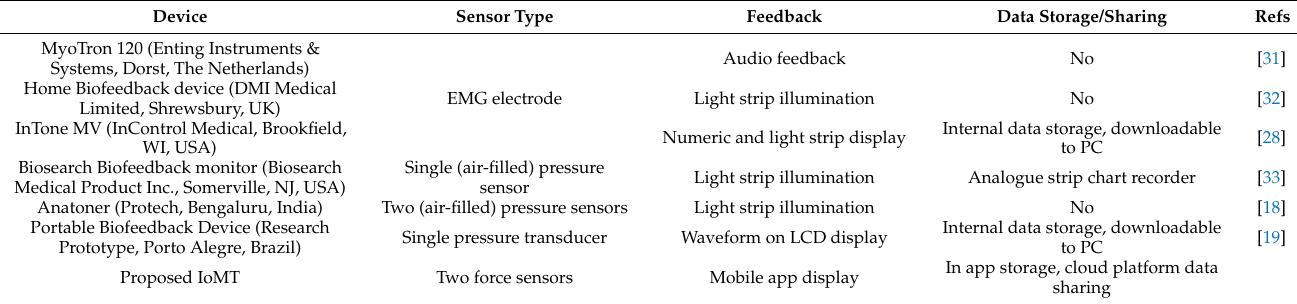
Table 1. Home anorectal biofeedback system and proposed